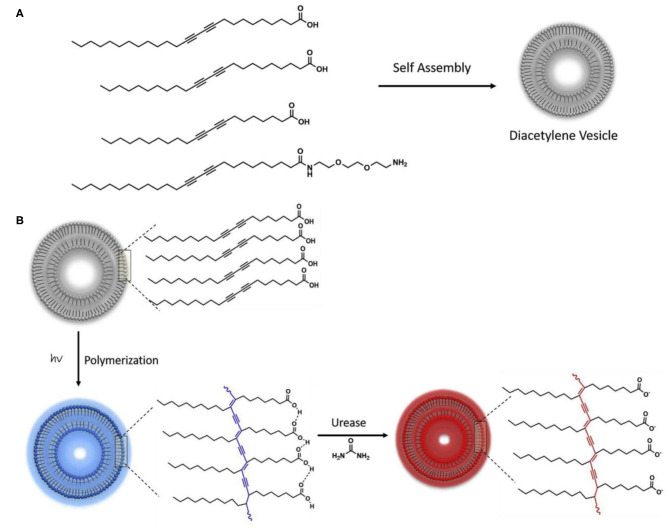
(A) Chemical structures of the diacetylene monomers including PCDA, TCDA, HCDA, and PCDA-EDEA. (B) Schematic illustration of PDA-based colorimetric sensing of urease. Reprinted with permission from Jannah and Kim (2019). Copyright 2019, Elsevier.